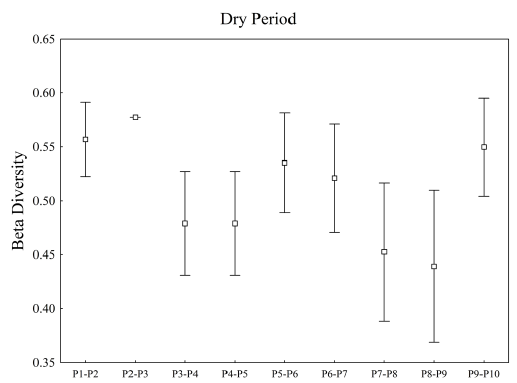
Figure 8. Species variation along the Paraná River during the dry period. The dots represent the mean values and the bars represent the standard deviations.